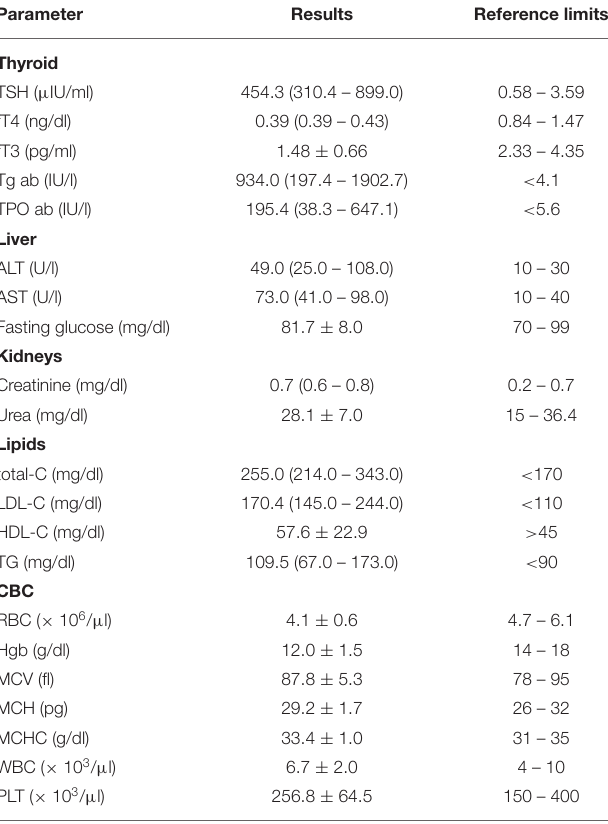
TABLE 1 | Average values of all evaluated biochemical parameters in SH children. Parameter